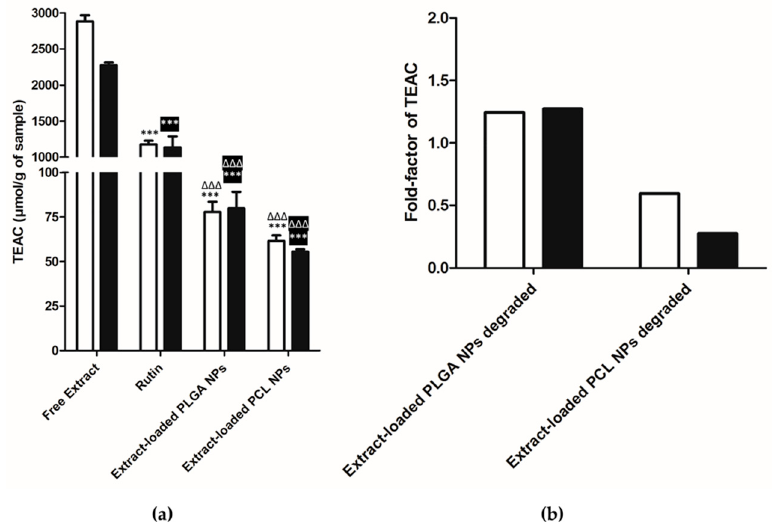
Figure 11. ( a ) Antioxidant activity of free extract, rutin, extract-loaded PLGA NPs and extract-loaded PCL NPs (TEAC ( µ mol / g of sample, mean ± S.D., n ≥ 3, *** p < 0.001, when compare free extract with other samples and ∆∆∆ p < 0.001, when compare rutin with other samples), ( b ) Fold-factor of TEAC when compared with respective extract-loaded NPs, ( (cid:3) ) ORAC and ( (cid:4) ) HOSC methods.